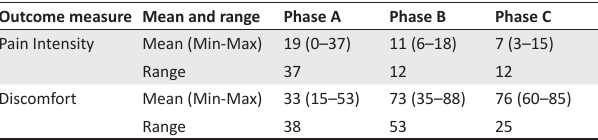
TABLE 4: Means and ranges per phase for the outcomes of pain and comfort.